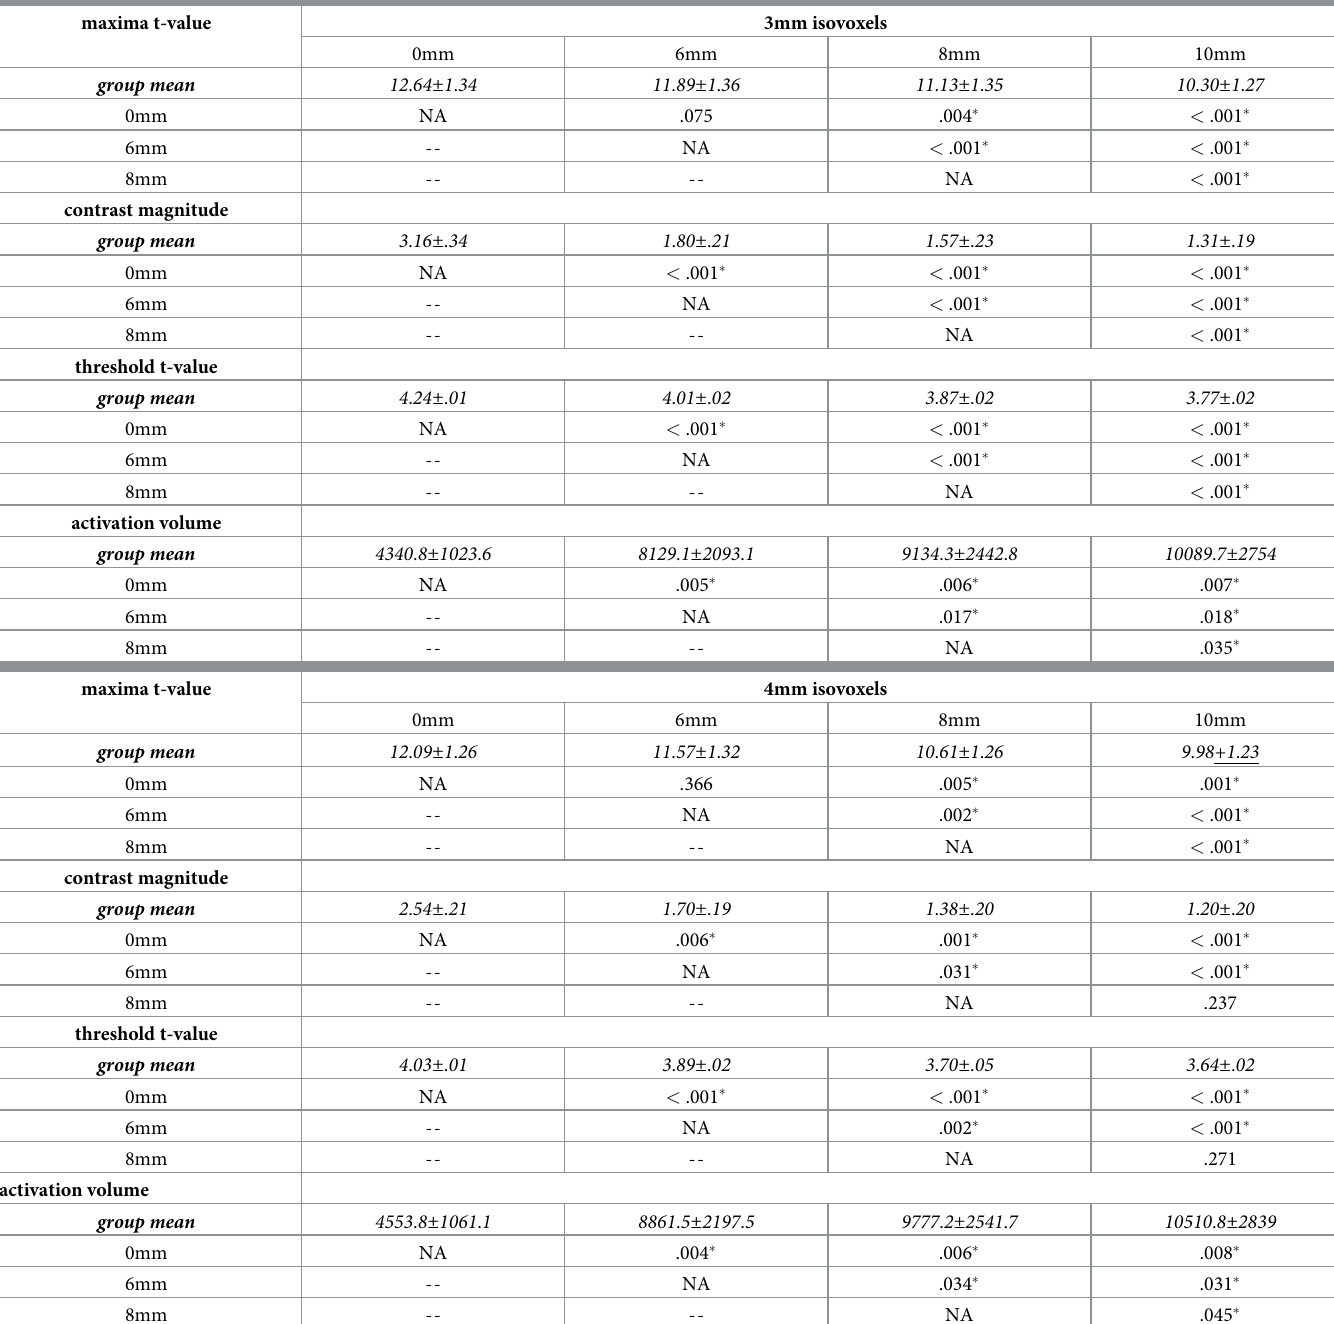
Table 3. Smoothing kernel effects on SMC activation during repetitive tapping. maxima